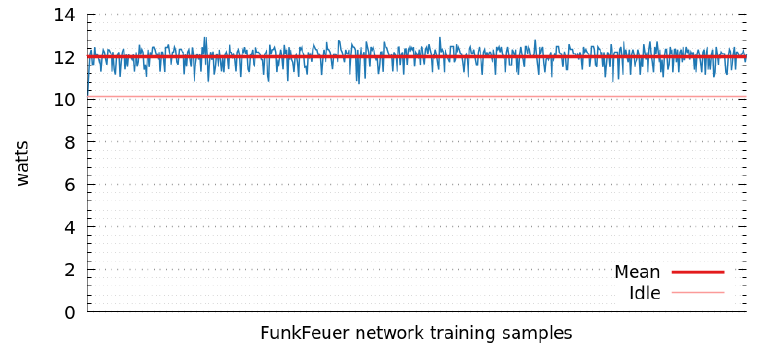
Figure 20. Energy consumption in watts for Training WEKA model: mean is 11.99 W, idle is 10.14 W, and difference is 1.86 W.